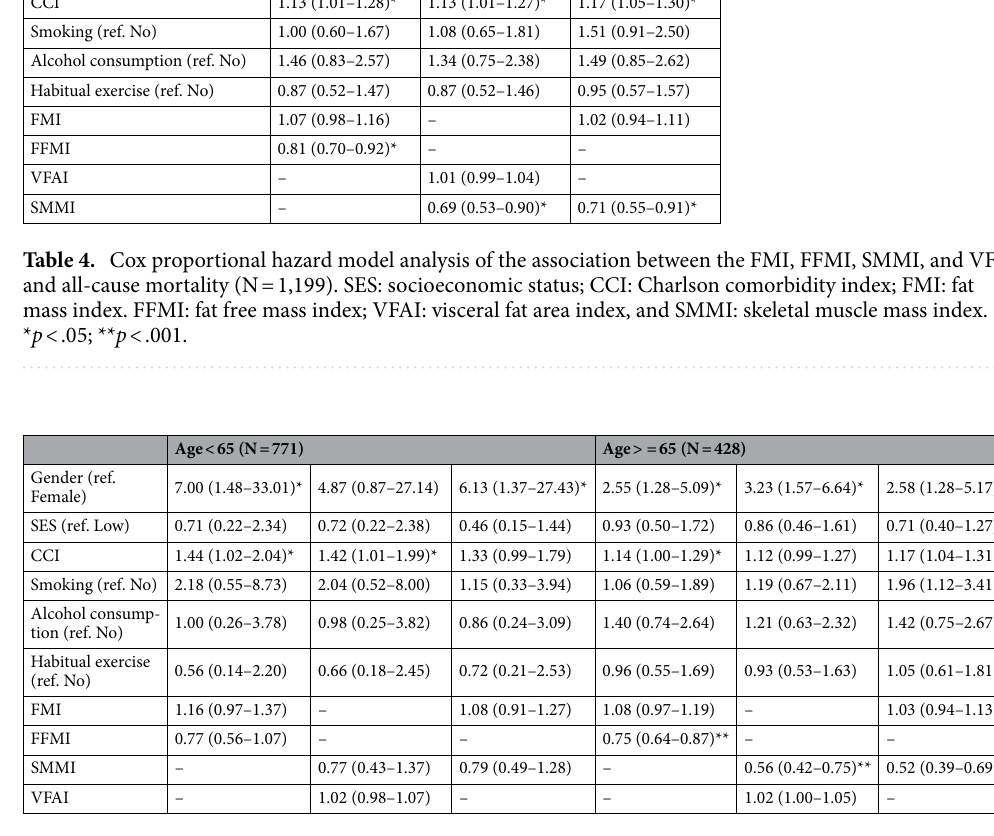
Table 5. Cox proportional hazard model analysis of the associations between the FMI, FFMI, SMMI, VFAI, and all-cause mortality by age. Data was represented as: HR (95%CI). SES: socioeconomic status; CCI: Charlson comorbidity index; FMI: fat mass index. FFMI: fat free mass index; SMMI: skeletal muscle mass index, and VFAI: visceral fat area index. *: p < .05; **: p < .001.